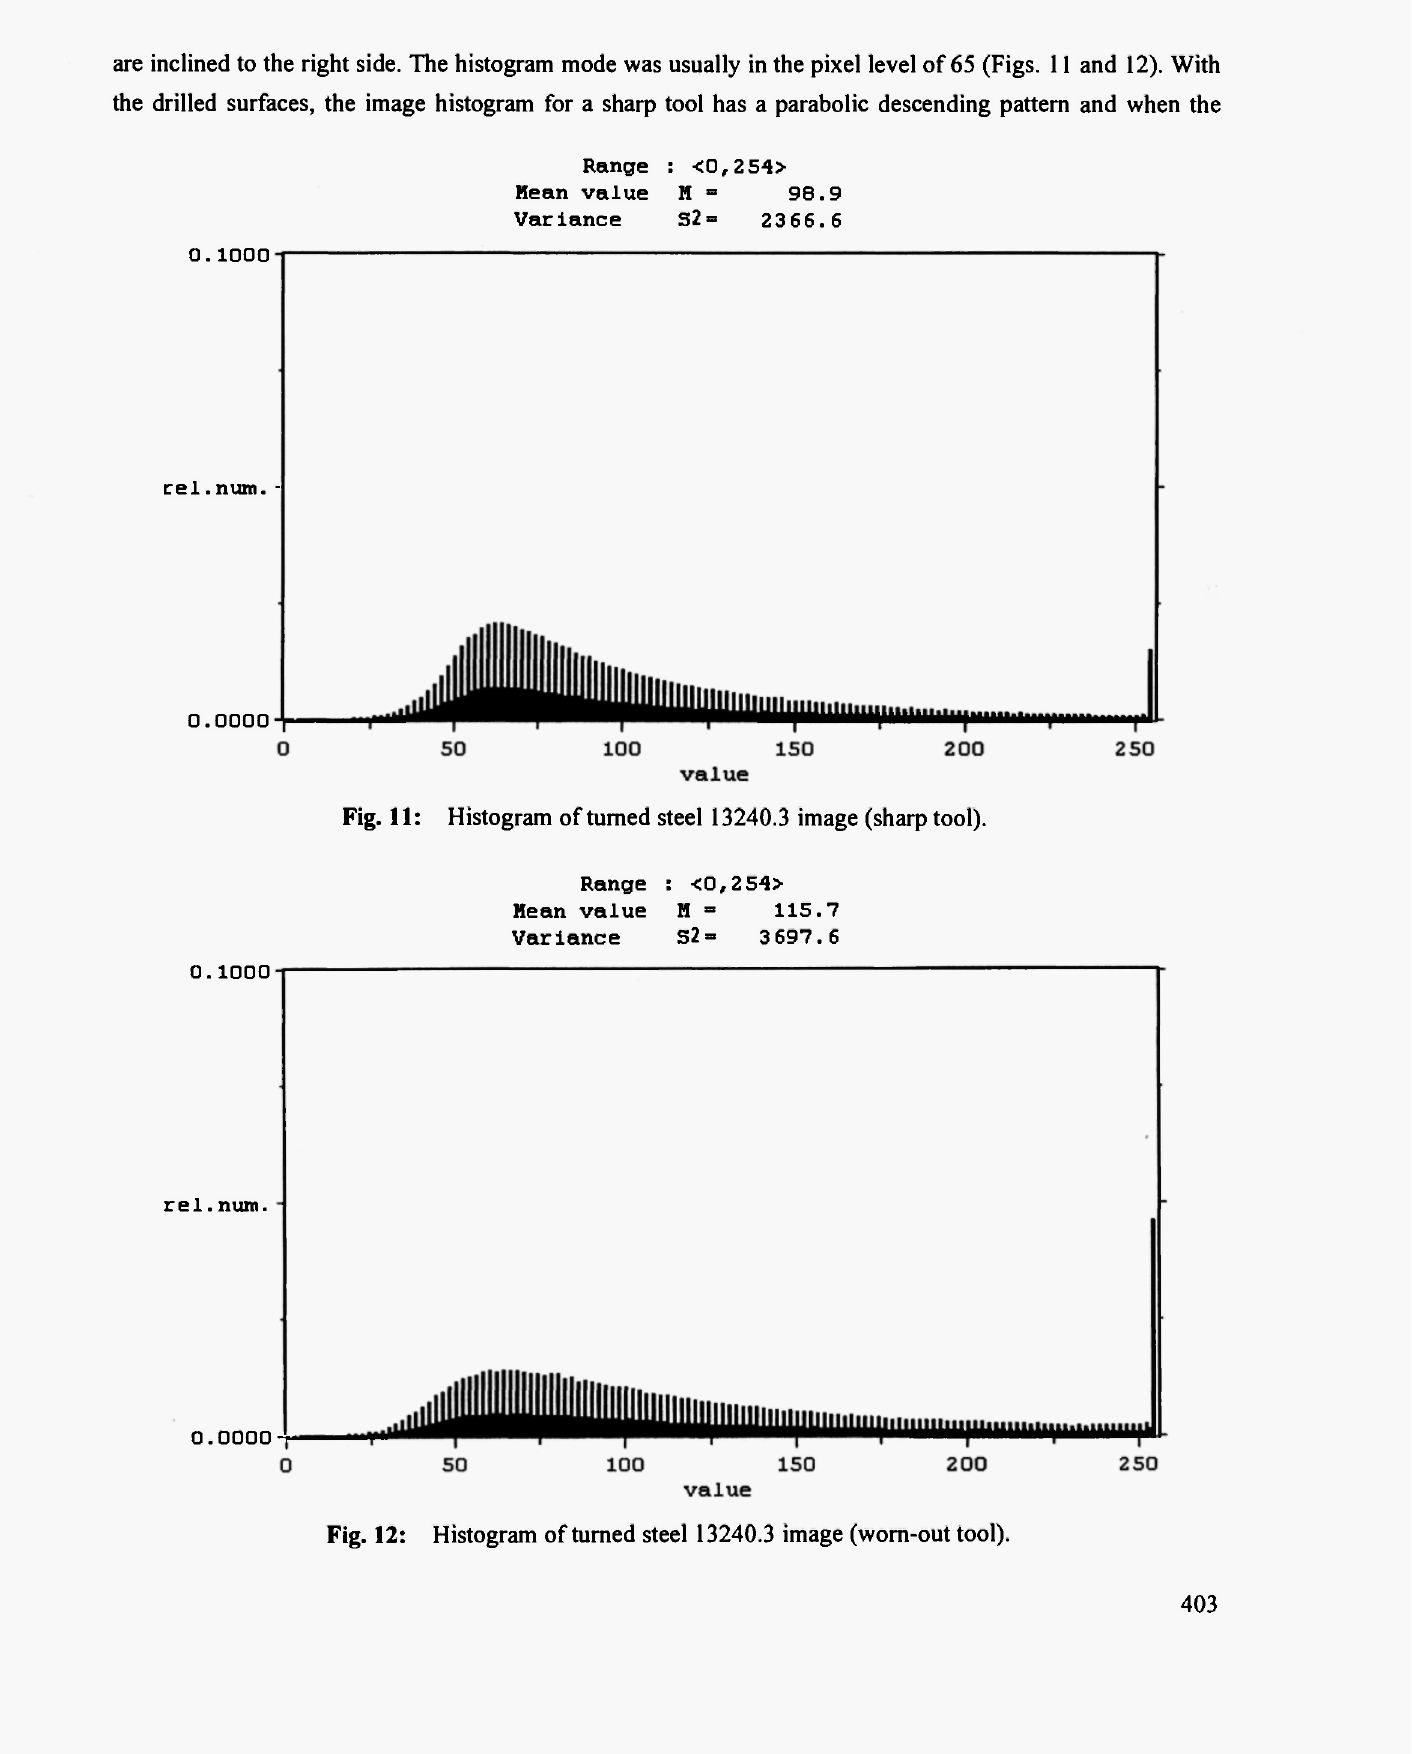
Fig. 12: Histogram of turned steel 13240.3 image (worn-out